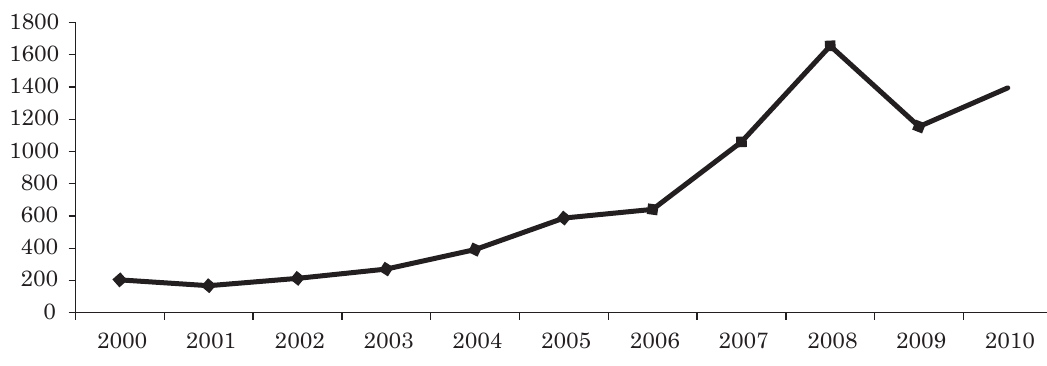
Figure 1. Evolution of residential property investments by foreigners in Malaysia, 2000–2010 (RM